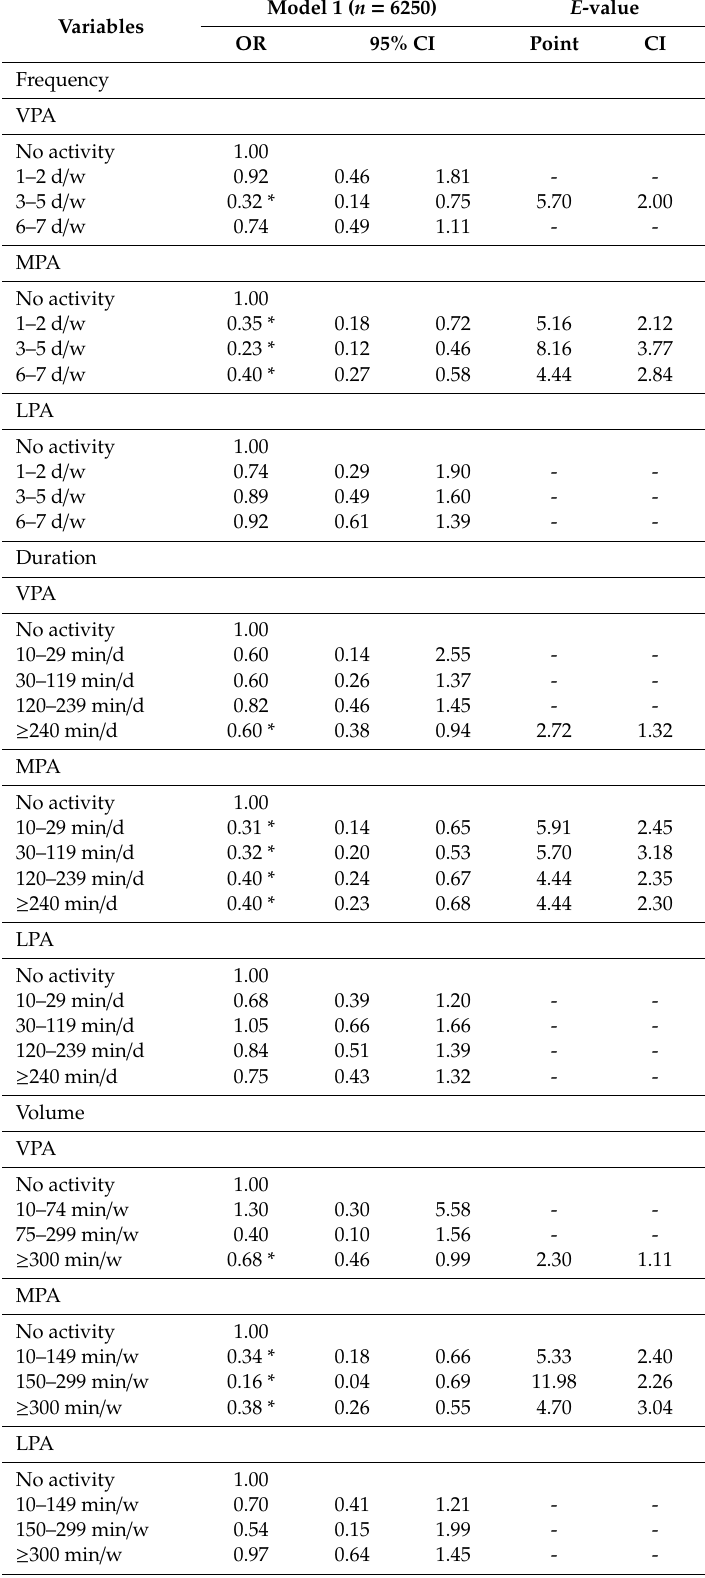
Table A2. E -values for the point